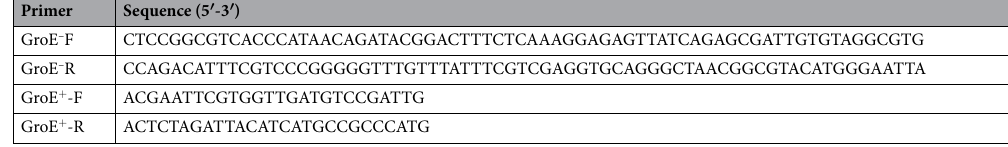
Table 3. List of primers used in the construction of engineered